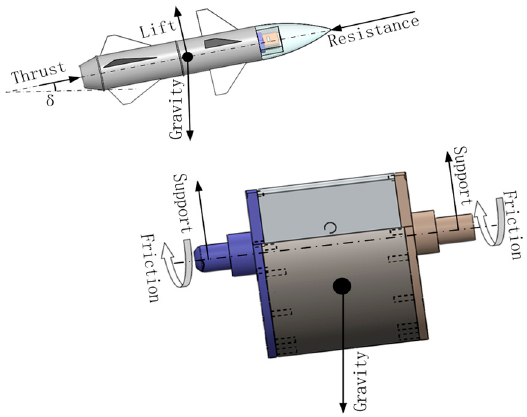
Figure 6. Diagram of main forces acting on missile and the SSP.